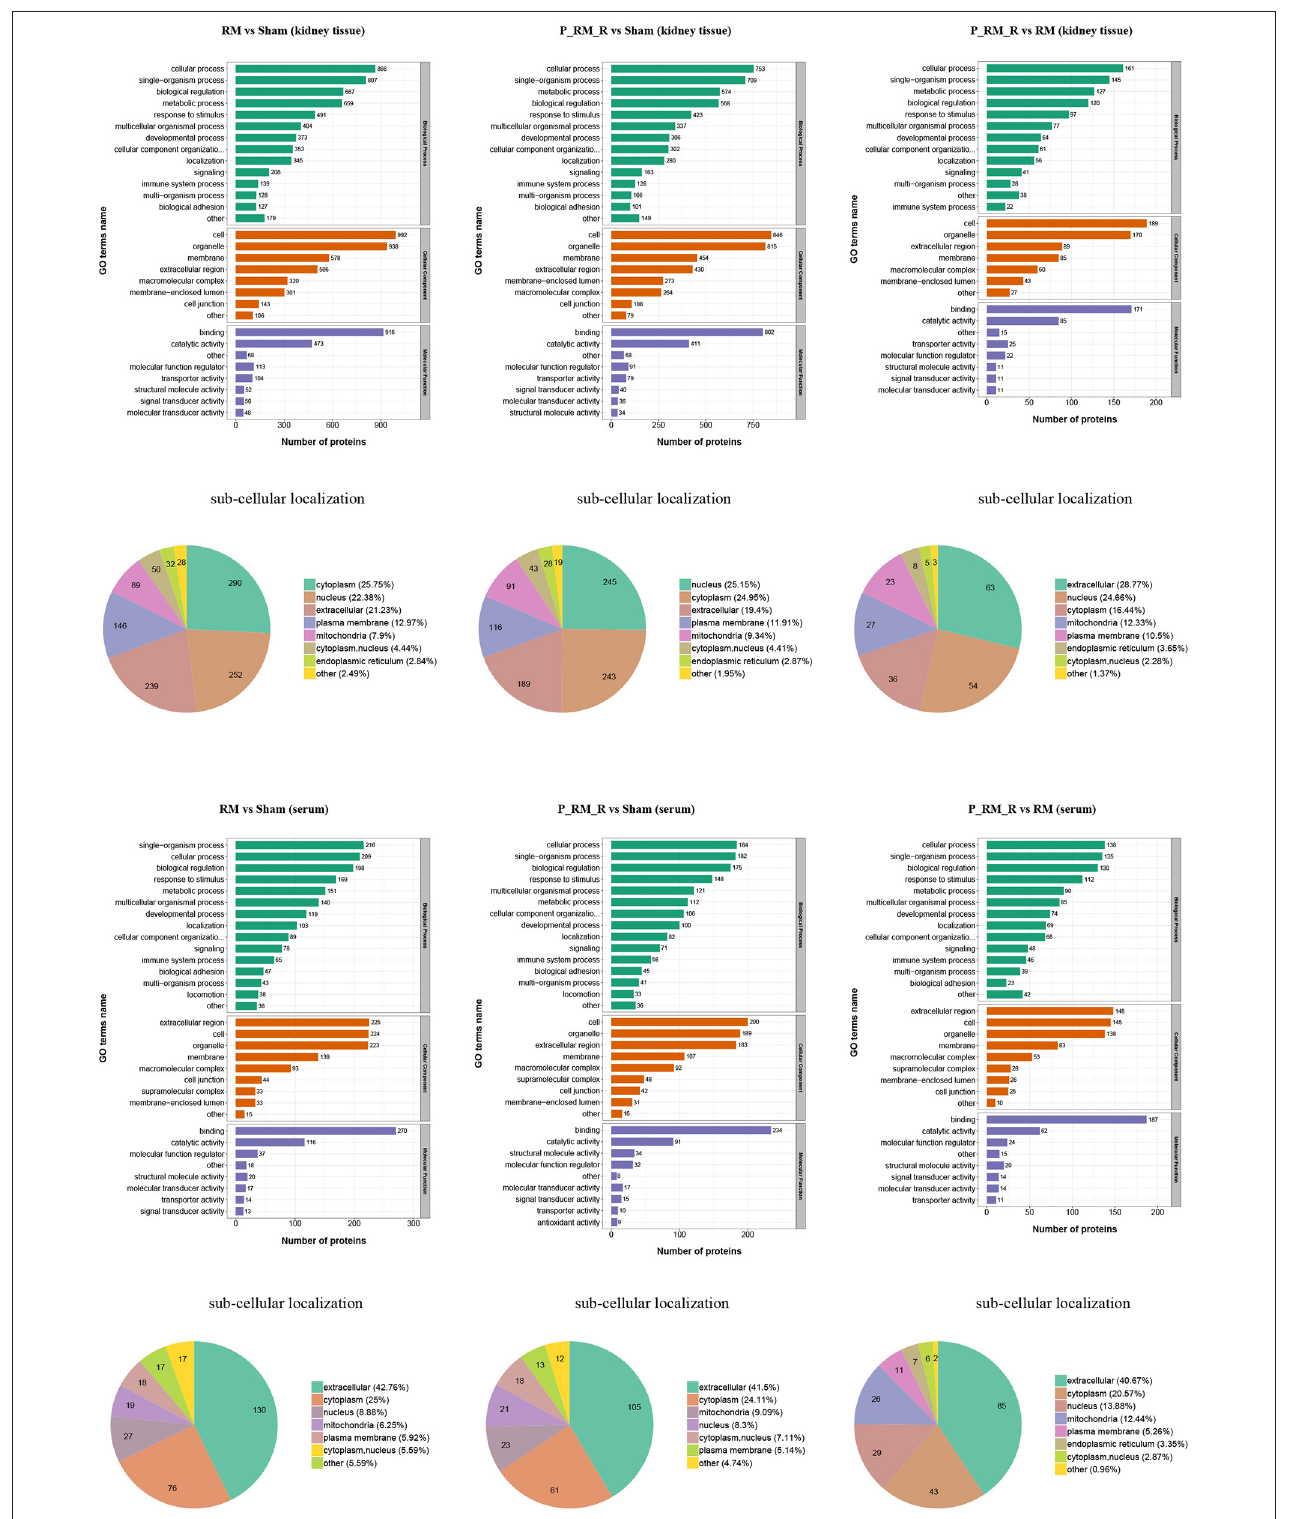
FIGURE 2 | Gene Ontology terms and subcellular localization of proteins in kidney tissue and serum. RM, rhabdomyolysis; P_RM_R, the mouse in the parabiosis model administered glycerol; P_RM_S, the other mouse in the parabiosis model supplying the exogenous biological renal support.